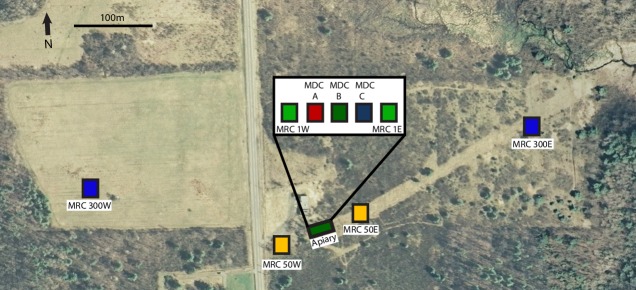
Birds-eye view of study site.It shows the array of three mite donor colonies (MDCs) and six mite receiver colonies (MRCs). All hive entrances faced south.